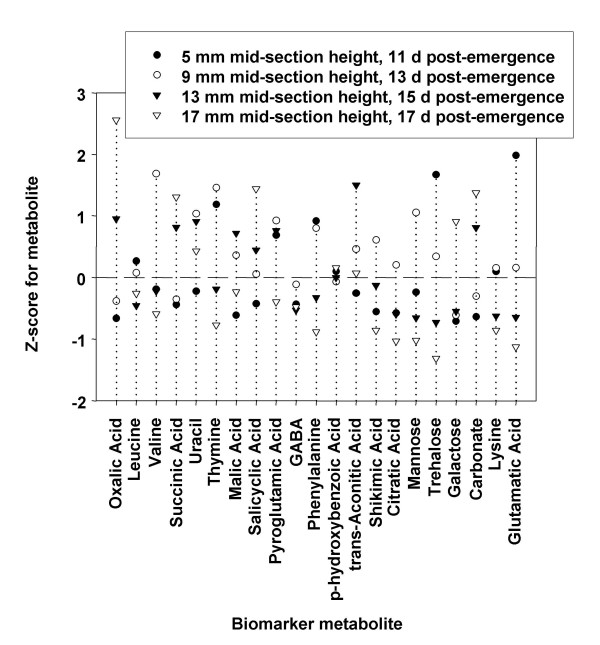
Magnitude and pattern of variation in biomarker metabolite concentrations in samples ranging in development. Four of the tissue samples representing a developmental range are profiled with respect to biomarker metabolite variation. The samples progress in height at mid-section of the sampled tissue and in days post-emergence, thus they represent a cross-section of the larger set of tissue samples. The biomarker metabolites are listed along the horizontal axis, and each dot plot shows the Z-scores for the biomarker metabolite concentration. The metabolites vary a lot in absolute concentration, so the Z-score is used to equalize the overall variation in concentration of the metabolites during the study. Thus the figure shows the pattern and magnitude of the variation among the presented tissues, but also the amount of this variation relative to that of the metabolite concentration for the whole study. For example, oxalic acid and glutamate both have a fairly wide range of Z-scores for these samples, although the pattern of variation is opposite.